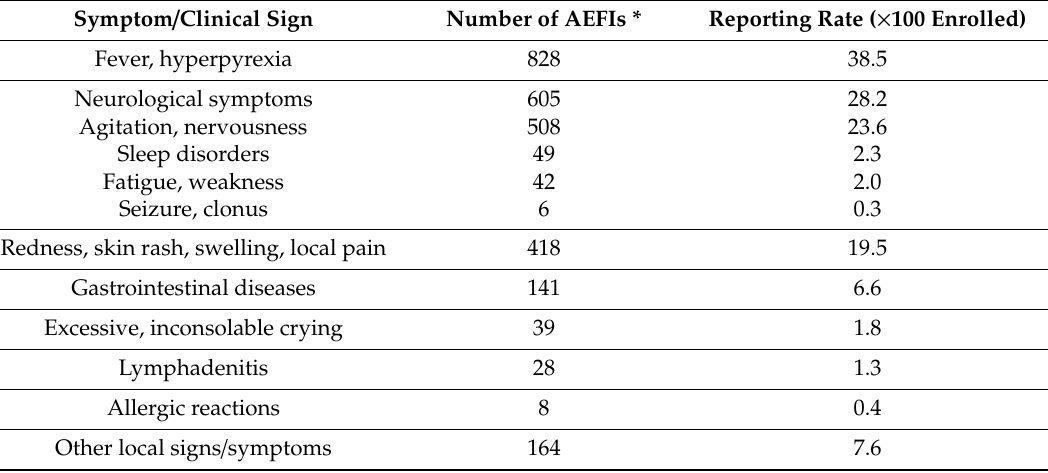
Table 1. Number and reporting rate of symptoms / clinical signs most frequently notified. Apulia Region, post-marketing active surveillance following measles-mumps-rubella-varicella (MMRV) immunization, 2017–2018.